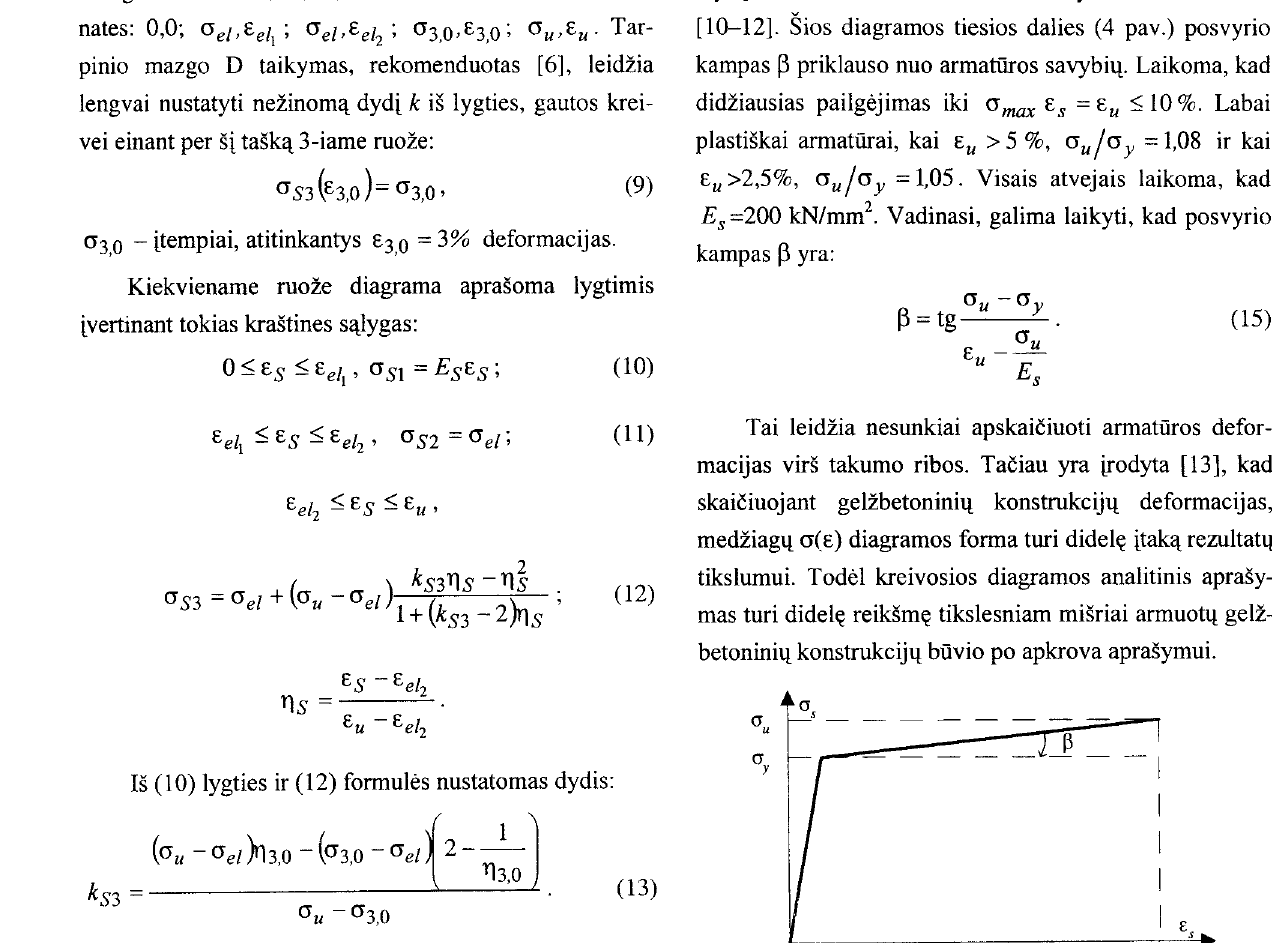
Fig 4. Stress-strain curve by Eurocode formula (15) Miisq atlikta 0(£) prik1ausomybiq analize rodo jq ivairov~, vertinant kai kurias armaturos savybiq charakte